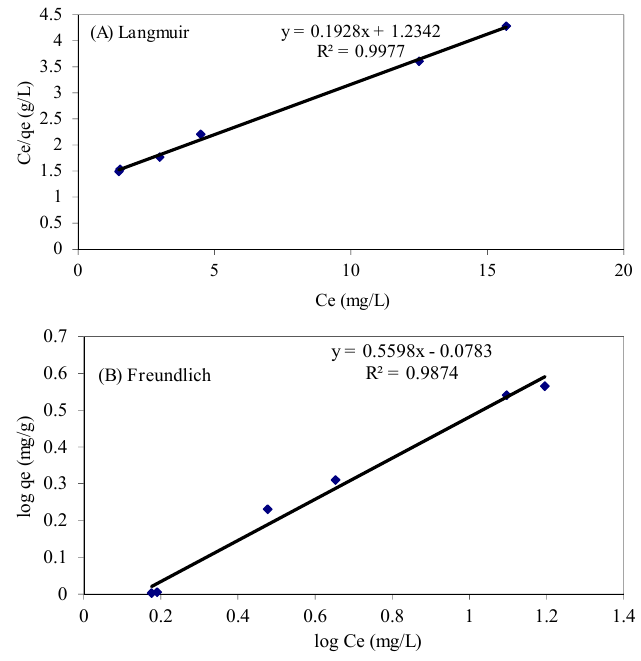
Fig. 9. Langmuir (A) and Freundlich (B) isotherm models for the adsorption of Cd 2+ on the adsorbent.